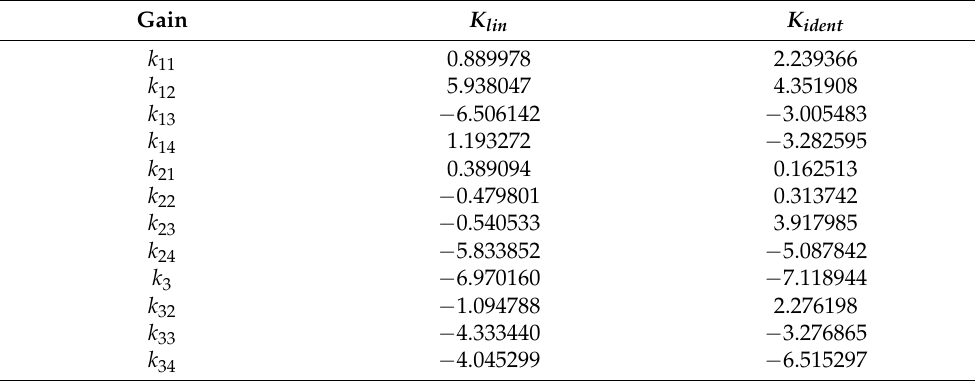
Table A5. Final gains of the observer obtained using method described in [21] ( K lin ) and obtained using method proposed in this study ( K ident